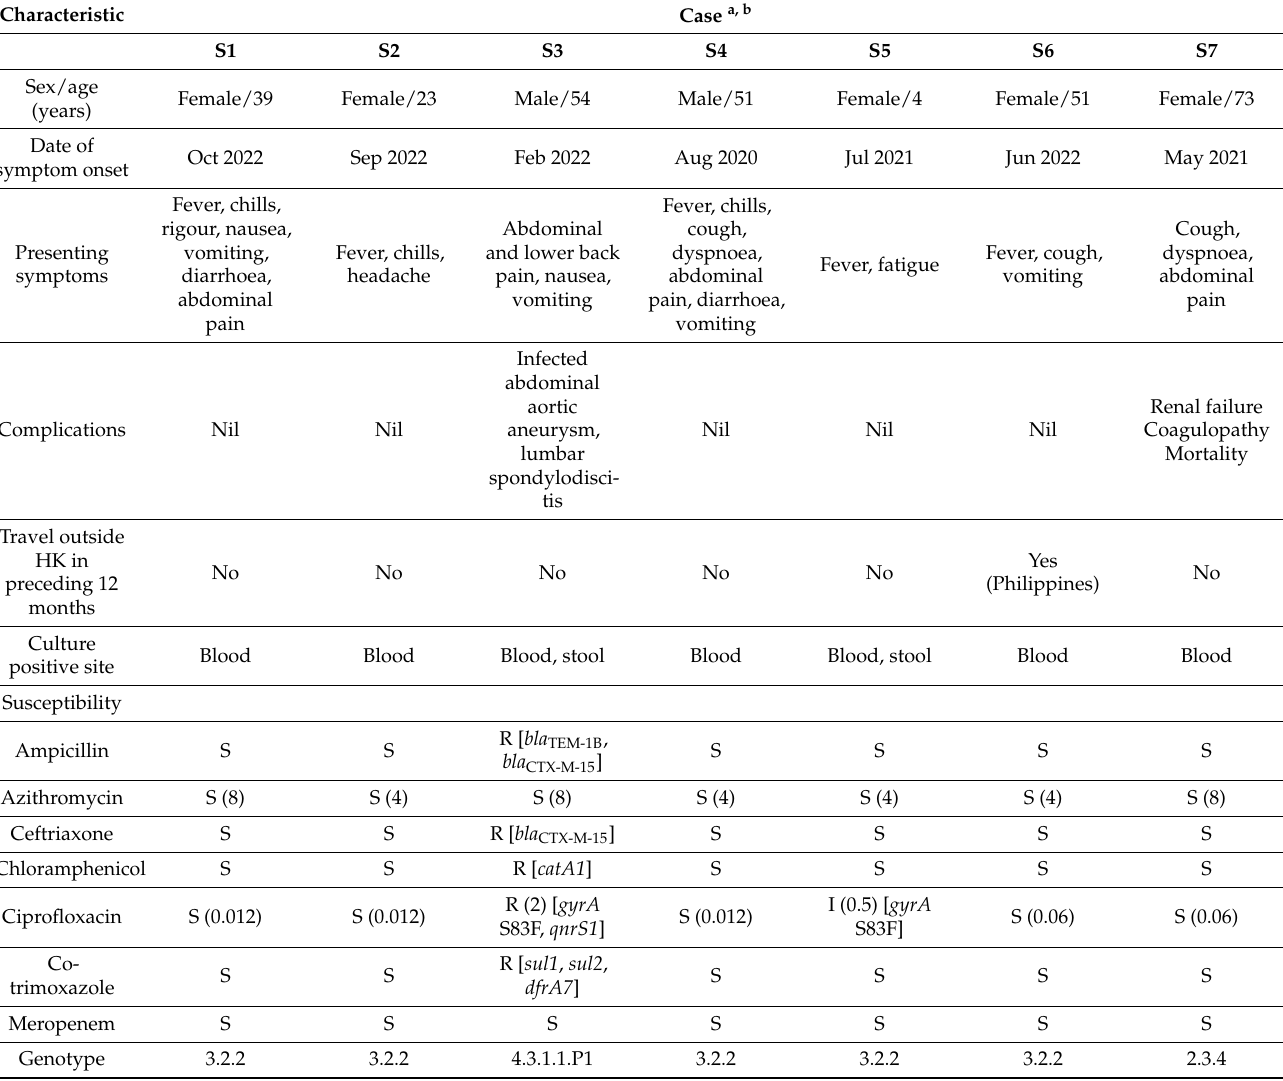
Table 1. Clinical and microbiological details of cases with Salmonella Typhi